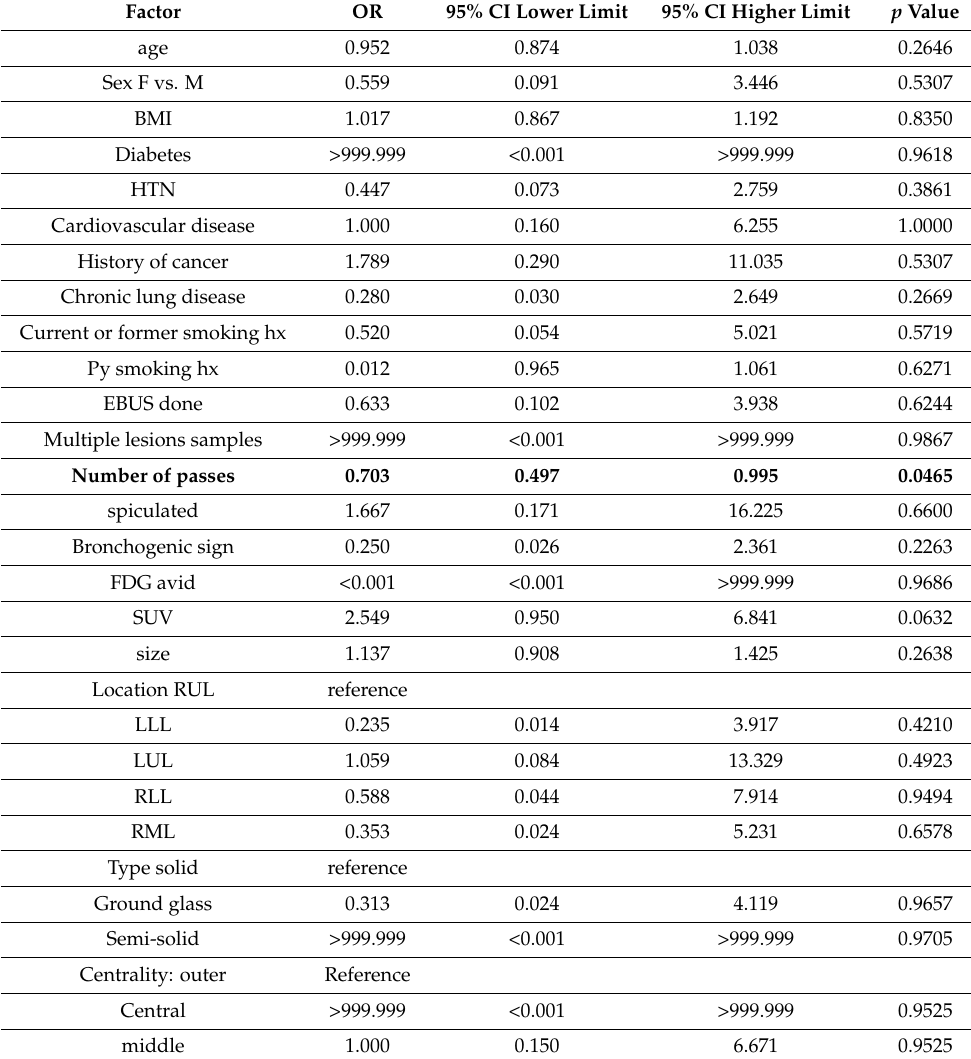
Table 3. Univariate analysis: Predictors of diagnostic